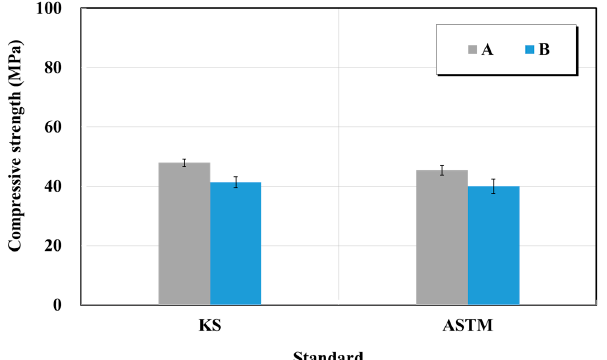
Figure 9. Compressive strength test results of structure restoration materials (repair mortar) obtained based on the KS and ASTM standards.